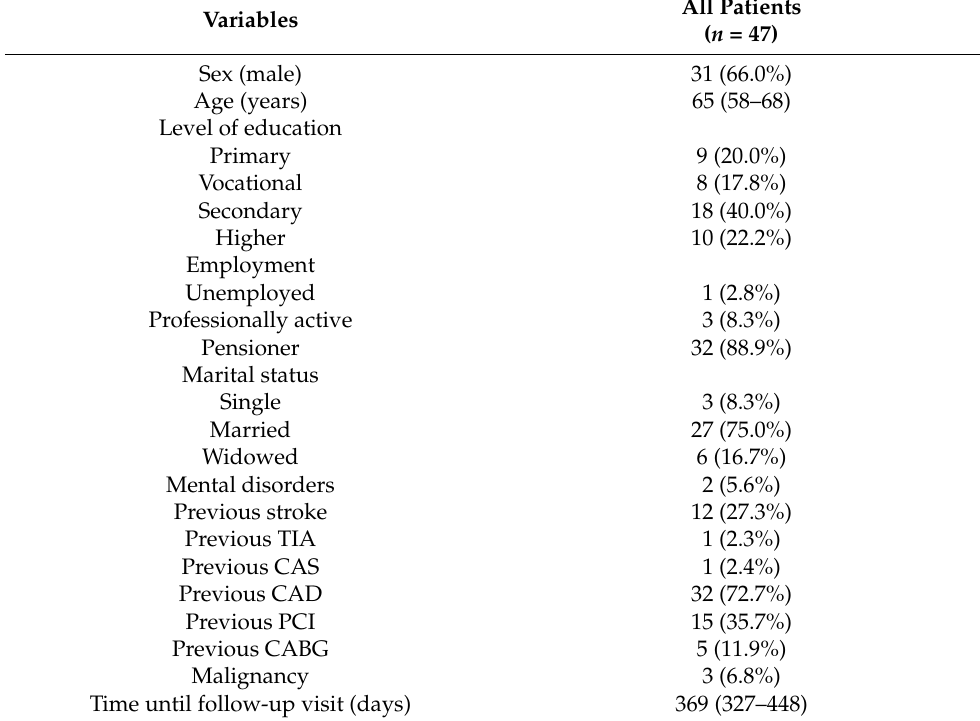
Table 1. Baseline